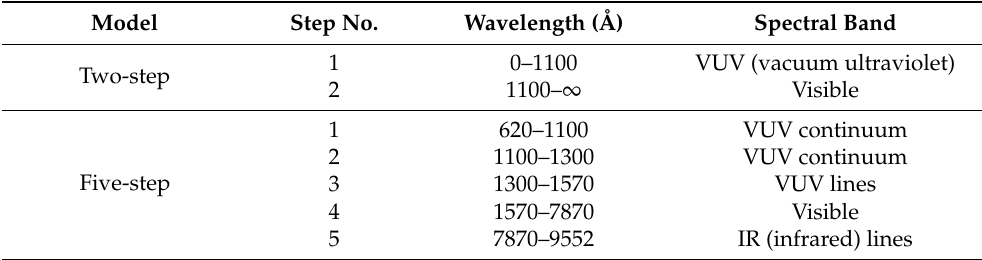
Table 1. Spectral regions of two-, five-, and eight-step